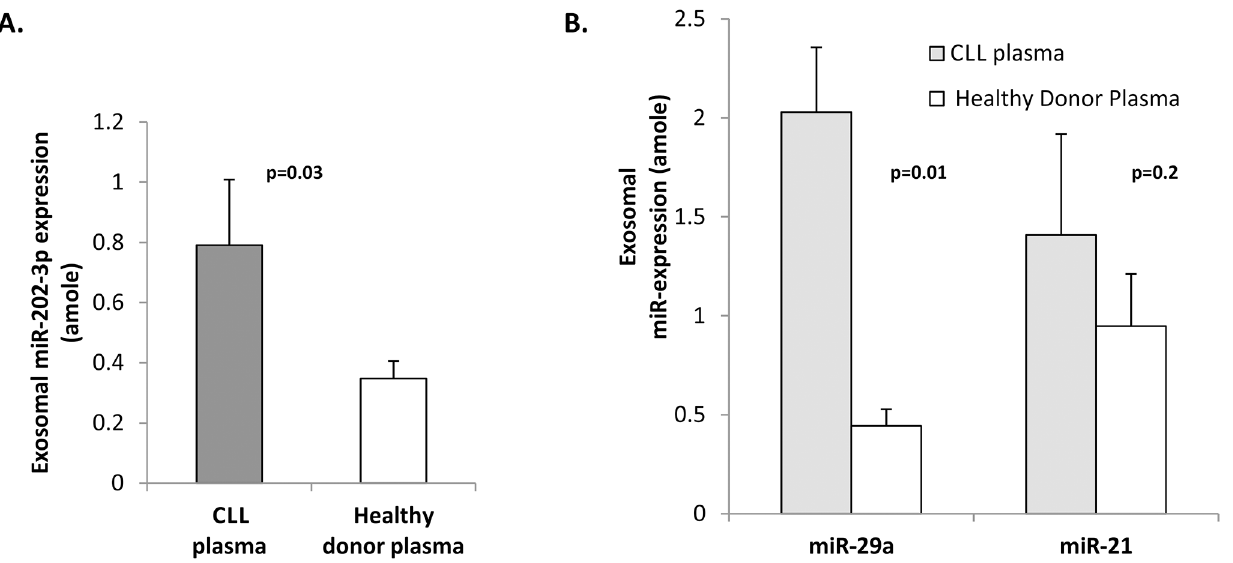
Fig 6. Expression of miRs 202-3p, 29a, and 21 in exosomes derived from plasma of CLL patients versus normal donors. (A) Exosomes sourced from plasma obtained from CLL patients or healthy donors (n = 3 each) were subjected to RT-qPCR analysis for absolute levels of miR-202-3p using a standard curve method. The levels of miR-202-3p are significantly higher in exosomes purified from CLL plasma (p = 0.03). (B) Absolute levels of miR-29a and miR-21 in exosomes harvested from CLL patient and healthy donor plasma (n = 3) were determined by RT-qPCR analysis. Standard curves for miR-29a and miR-21 were generated using the miRVana TM miRNA reference panel v9.1. Statistical analysis was performed using an unpaired t-test and yielded p values of 0.01 and 0.2 for miR-29a and miR-21 respectively.